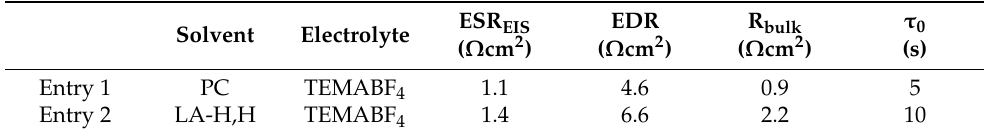
Table 4. EIS results normalized for the electrode